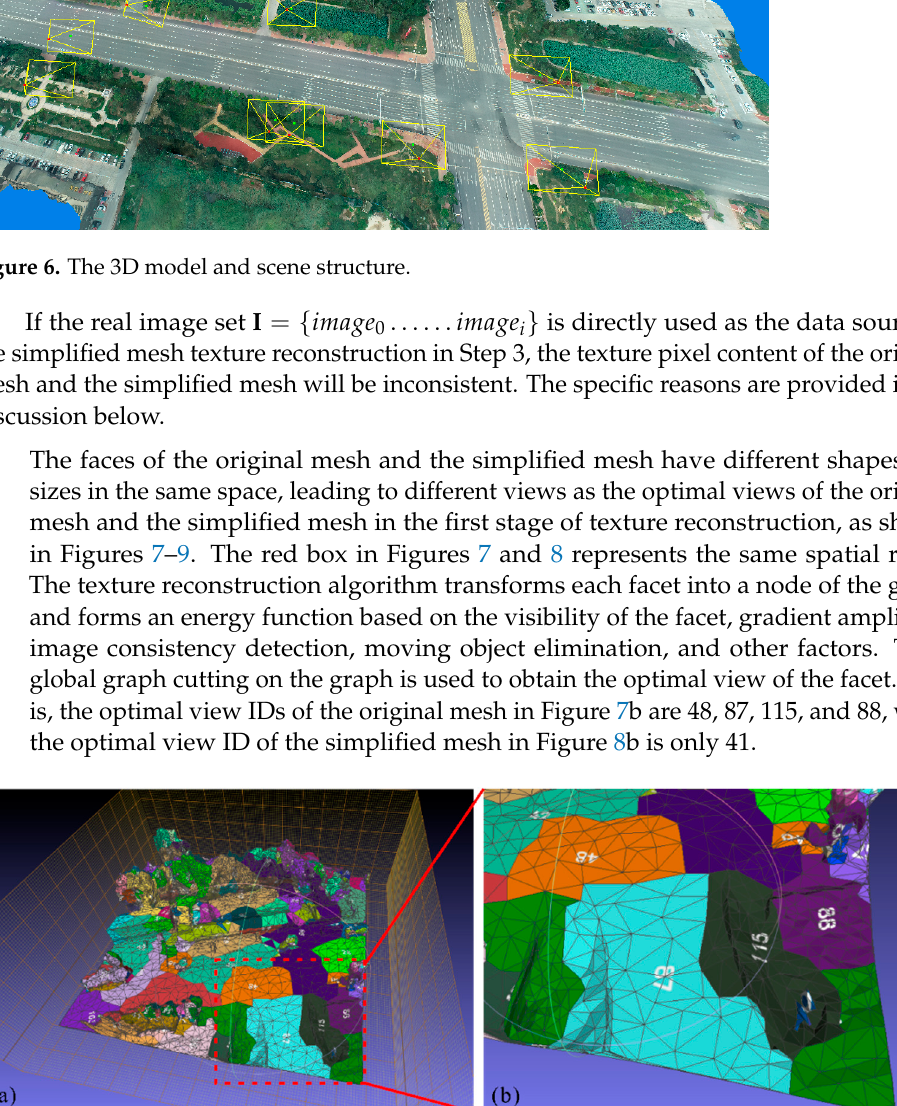
Figure 8. Best view ID of the simplified mesh facets: ( a ) whole drawing; ( b ) partial enlarged draw- ing. (2) Data collection by devices such as UAVs or mobile terminals is affected by the time dimension, and images collected at different times in the same area will contain dif- ferent information such as vehicles, pedestrians, dynamic shadows, and changes in road wetting and dryness, as shown in Figure 9a,b. Therefore, the pixel content ex- tracted from different images for the same facet may be different. Figure 9. Images acquired at different times in the same area. ( a ) This image includes moving cars on the road and no water. ( b ) This image includes water on the road and no moving cars. Considering the above two aspects and according to Reason (1) of the analysis, the original and simplified meshes in the red box will take different views as the optimal view of the facet. According to Reason (2), the pixel content of the facet extracted from different images is different because the image pixel content collected at different times in the same space is different. As a result, the textures have inconsistencies in pixel content.